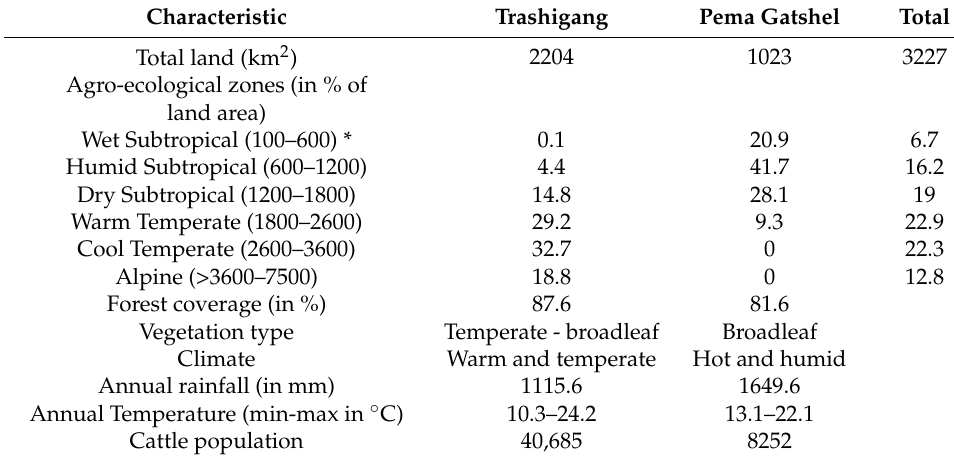
Figure 1. ( a ) Map of Bhutan showing the study area (pink shade) and; ( b ) Elevation map of the study area showing tick sampling sites (black dots). The map was prepared using Quantum GIS, QGIS Development Team (2019), QGIS Geographic Information System, Open-Source Geospatial Foundation Project (http://qgis.osgeo.org (accessed on 28 January 2021)) and was not taken from another source. Table 1. Geographic and climatic characteristics of the study area.